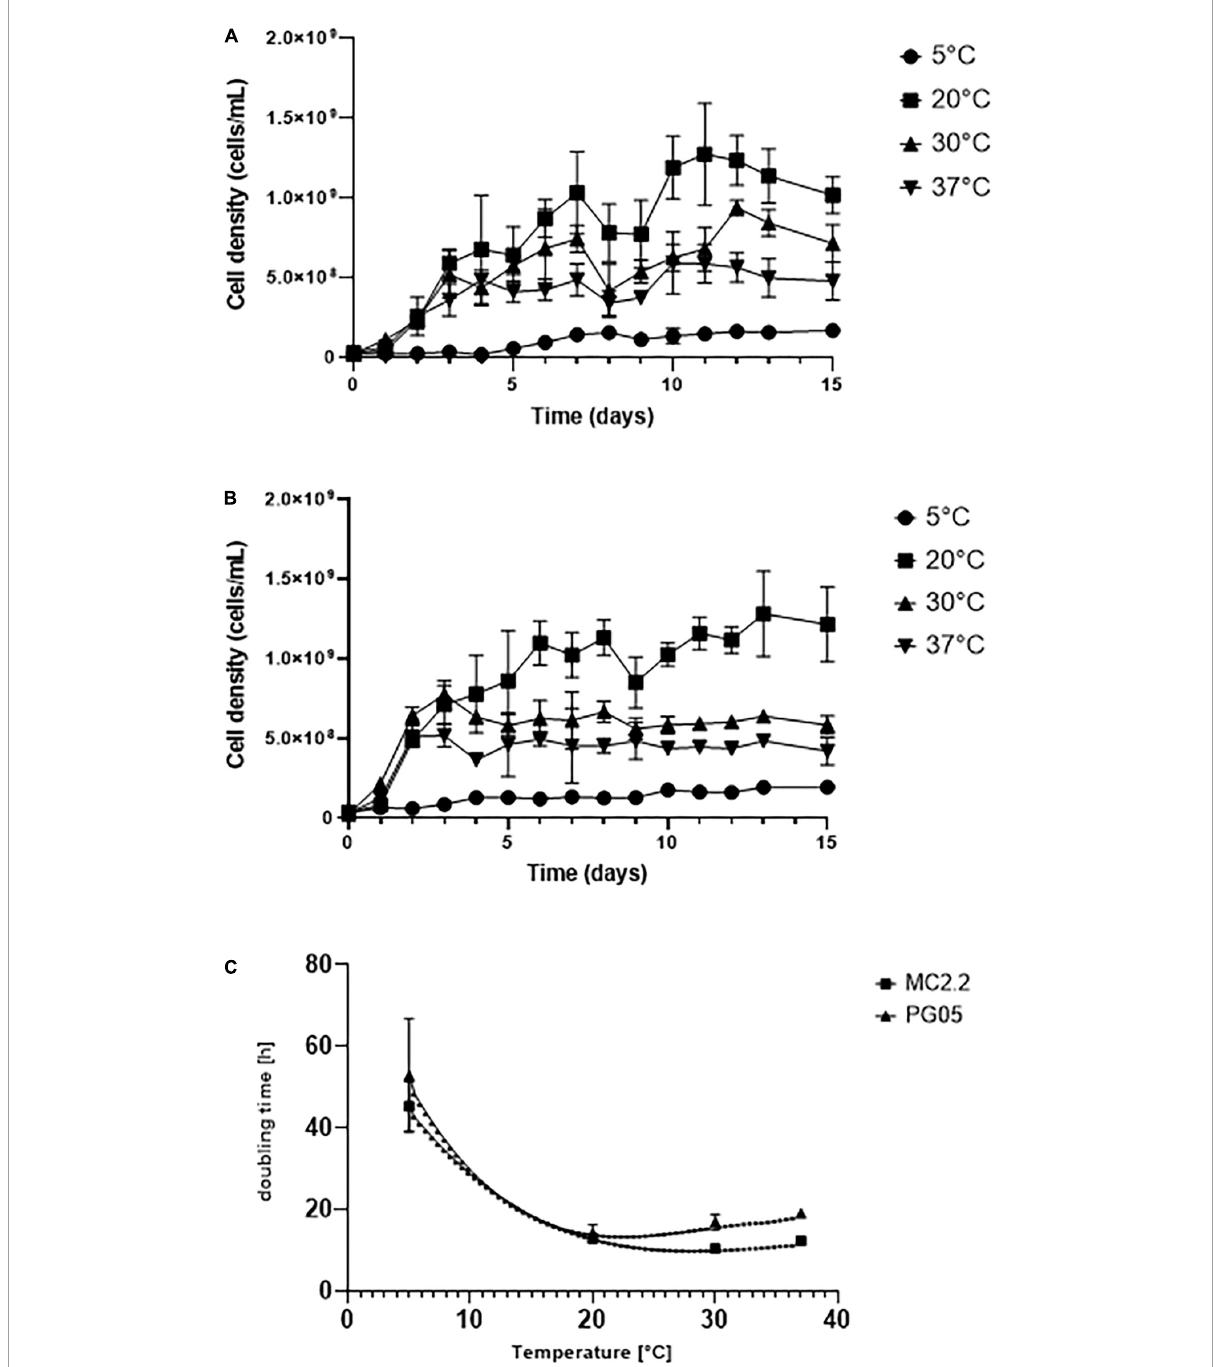
FIGURE3 Growth of Acidithiobacillus strains incubated at different temperatures. (A) PG05. (B) MC2.2. (C) Effect of the temperature on doubling times of the strains.